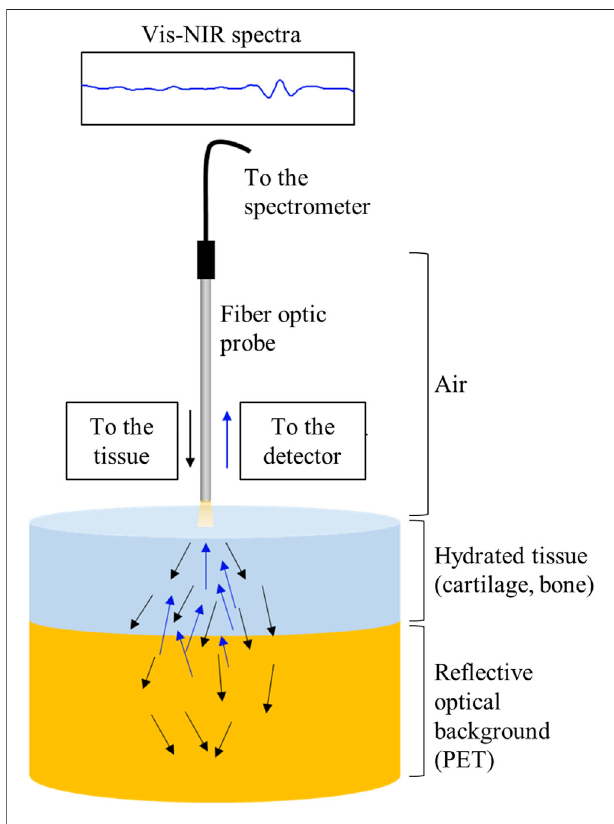
FIGURE 1 | Schematic of light scattering through cartilage tissue and a semi-in fi nite re fl ecting surface.